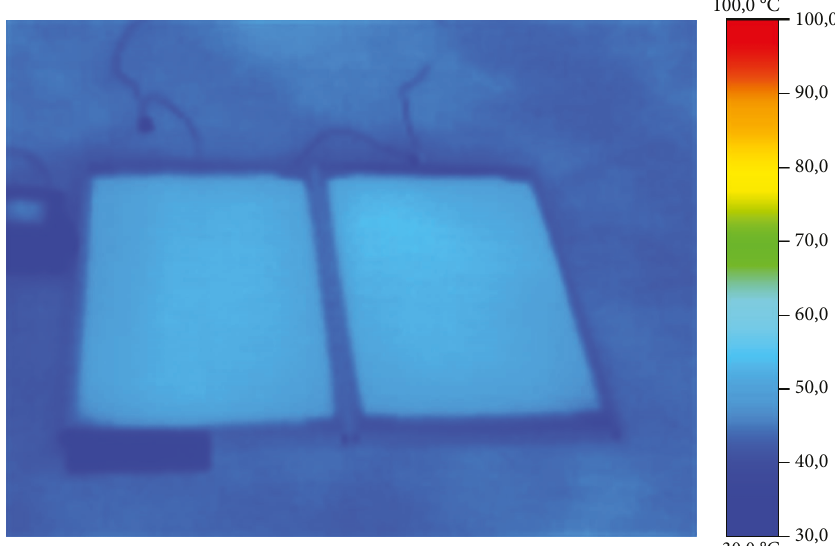
Figure 5: Thermographic image obtained when the two PVUs operate in the MPP. 26 September 2017, Aversa (CE), Italy. S = 600 W/m 2 and ambient temperature T amb = 25 ° C .